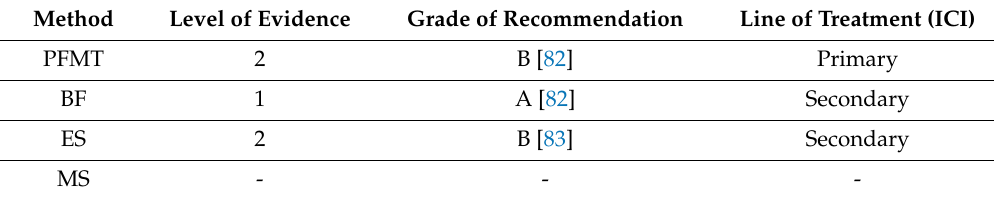
Table 9. Quality of evidence of physiotherapy techniques in FI in the ICI-ICS standards. Method Level of Evidence Grade of